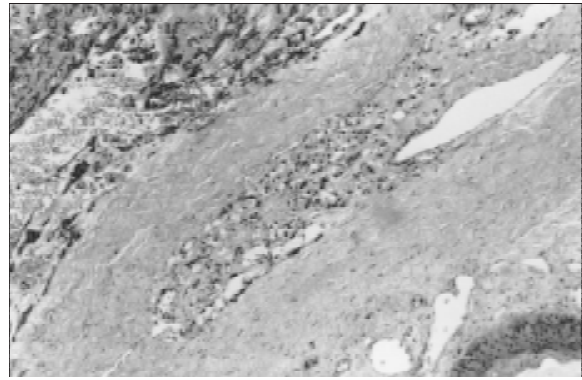
Figura 2 – Infiltração da esclera por estruturas tubulares neoplásicas (H&E 100x)